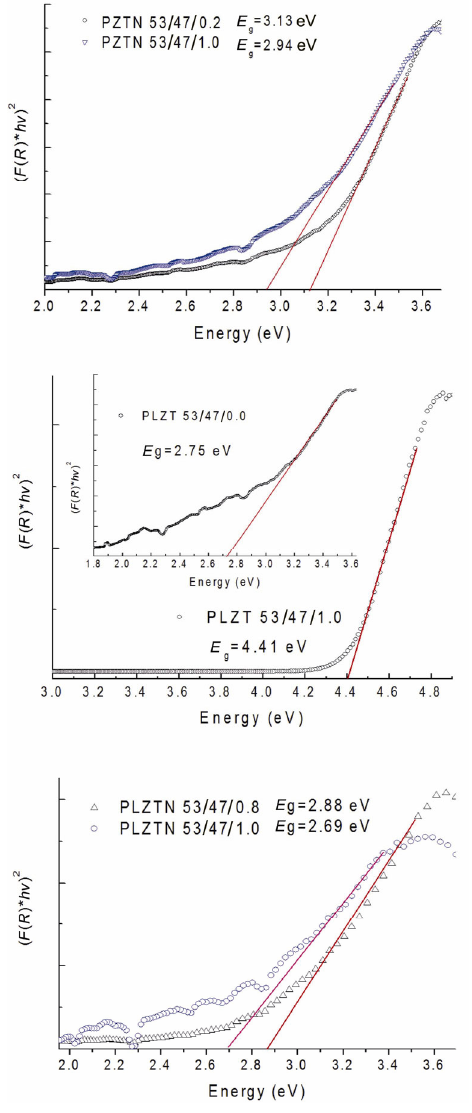
Fig. 7 Tauc plot for PZTN, PLZT, and PLZTN systems with different dopant concentration, assuming direct band